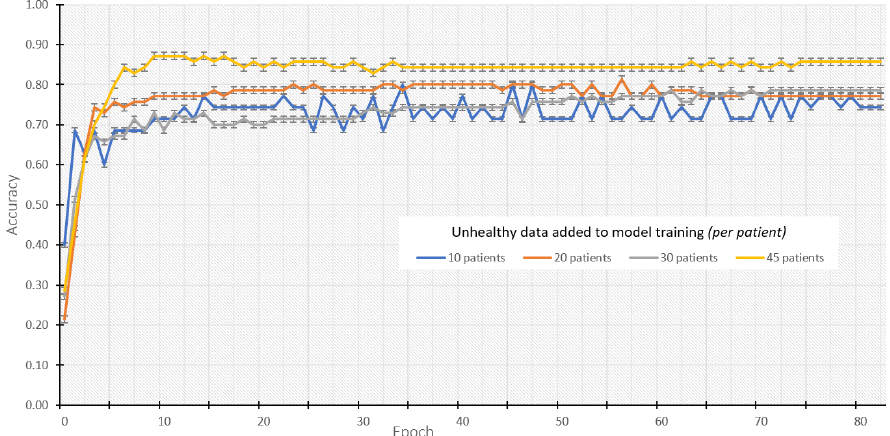
Figure 7. Validation accuracy curve of unhealthy data added to model training of healthy data.